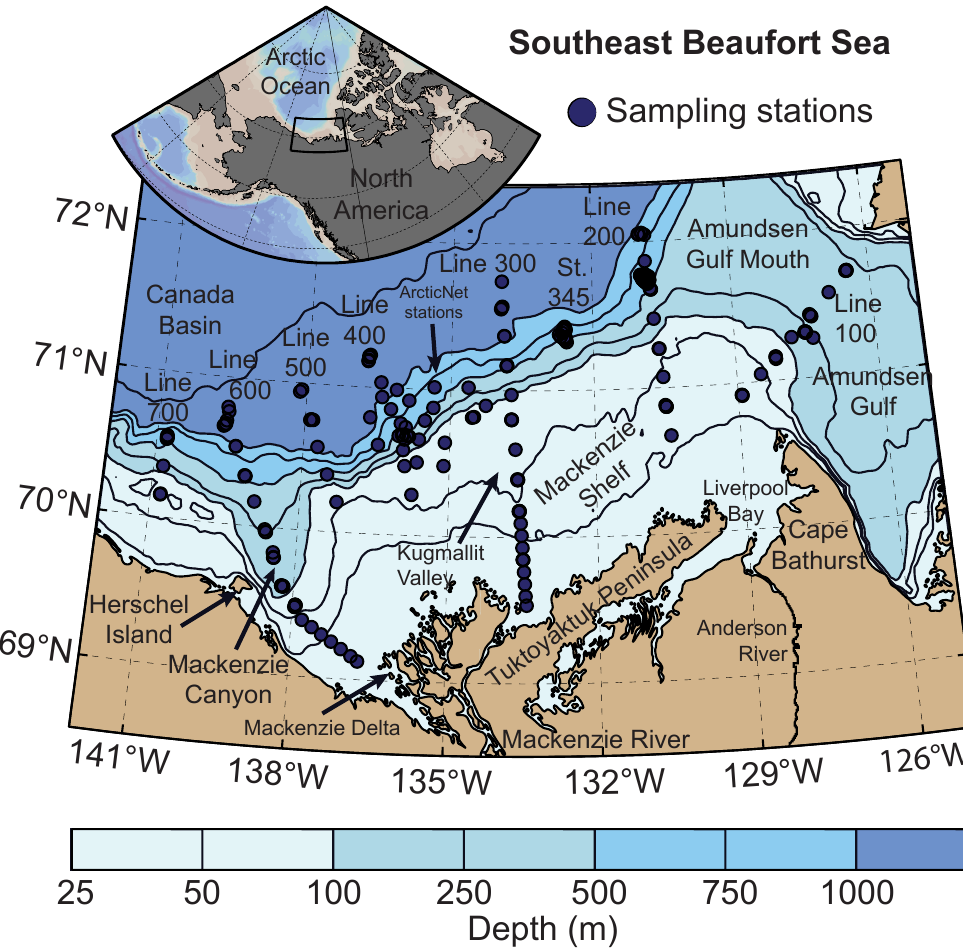
Figure 1. Map of the Mackenzie Shelf region (Beaufort Sea, Arctic Ocean) with position of sampling stations visited in July–August 2009 as part of the ArcticNet–Malina campaign. The ArcticNet sampling stations were located within the exploration license area EL446, whereas transects 100–700 and station 345 correspond to the Malina sampling grid. On each Malina transect, station numbers are listed in descending order from south to north (e.g., stations 170 to 110 from south to north on line 100). In this study, we used the following geographical limits when discussing the spatial variability: (i) the boundary between the shelf and the slope/basin is delineated by the 100m isobath; and (ii) the western, central and eastern regions correspond to the areas delimited by 136–141 ◦ W, 131–136 ◦ W and 126–131 ◦ W,